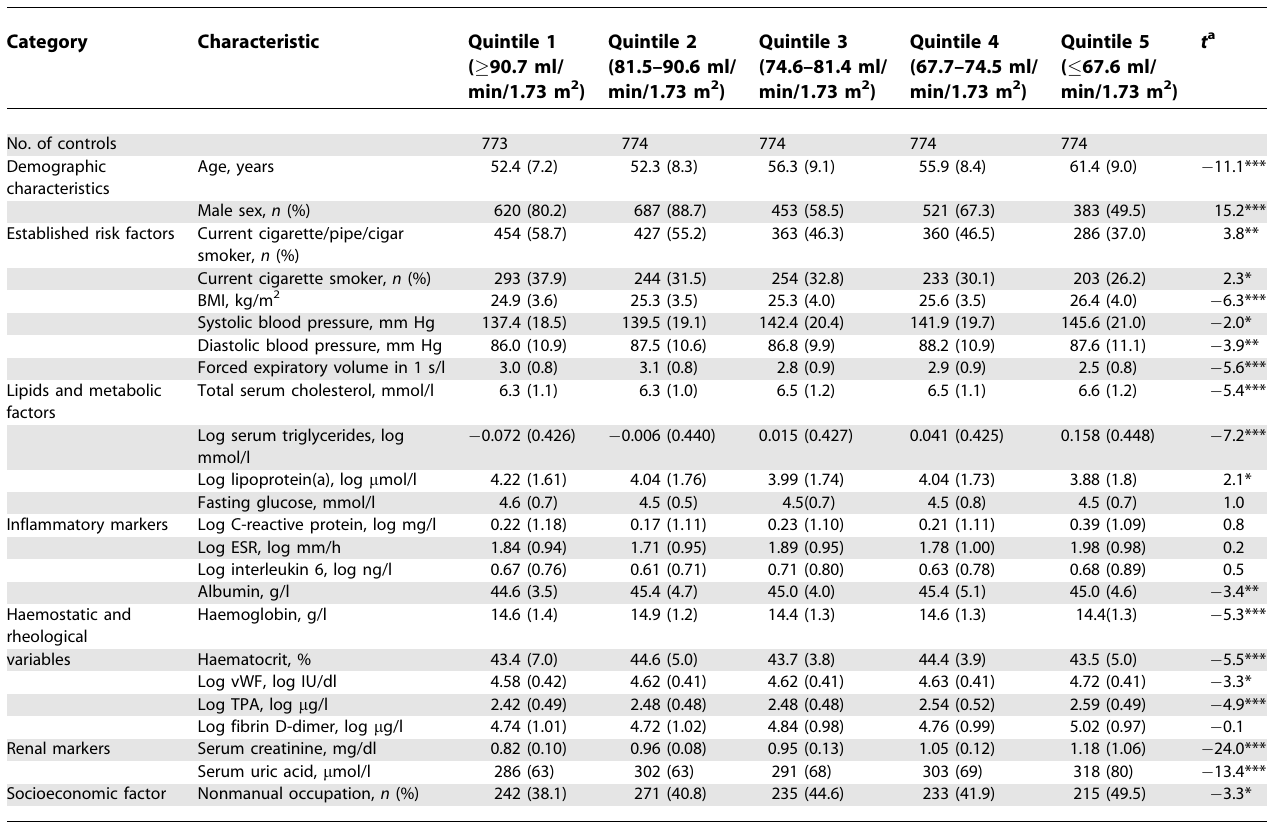
Table 2. Baseline Correlates of eGFR MDRD in Controls